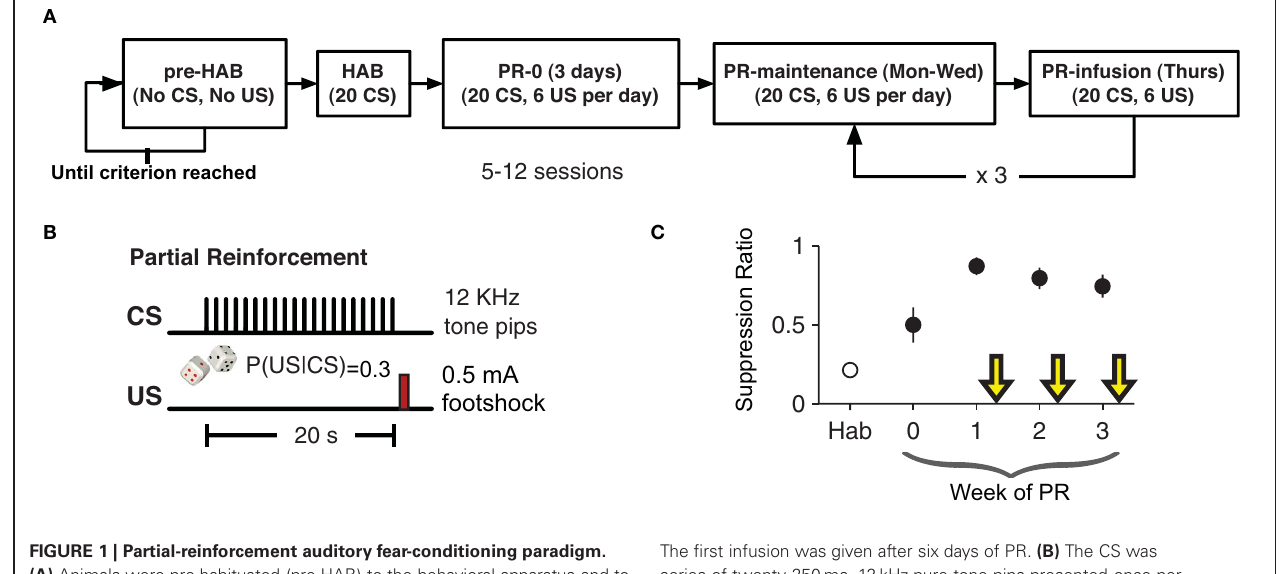
FIGURE 1 | Partial-reinforcement auditory fear-conditioning paradigm. (A) Animals were pre-habituated (pre-HAB) to the behavioral apparatus and to the orange drink. This continued until they reach a criterion of licking consistently for 1h. Habituation (HAB) consisted of 20 presentations of the CS with no reinforcement. The next day partial reinforcement (PR) fear-conditioning began. Each training session consisted of 20 presentation of the CS with a 30% probability of the CS being followed by the US.